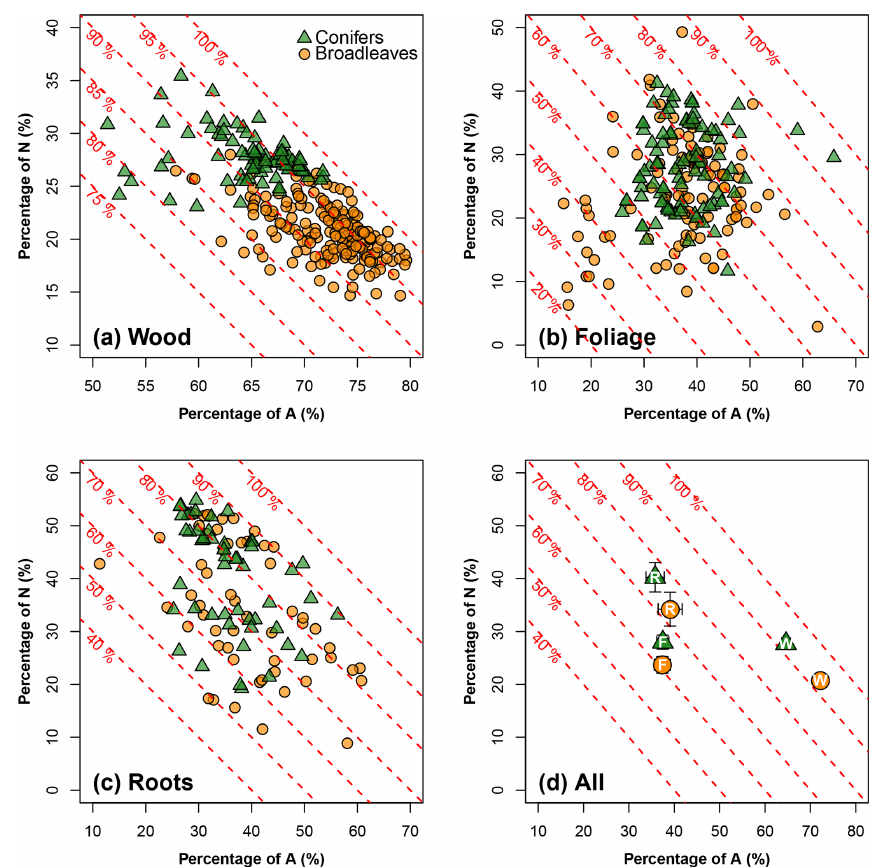
Figure 2. A meta-analysis of the carbon composition for northern temperate tree species: the x axis represents the percentage of acid- hydrolyzable compounds (e.g., cellulose, noted as A; in %), and the y axis represents the percentage of non-soluble and non-hydrolyzable compounds (e.g., lignin, noted as N; in %). The oblique red dashed lines show the sum of A and N and their values. The remaining percentage, i.e., 100 − (A + N) , refers to the portion of non-polar extractives, ethanol or dichloromethane compounds (E), and water soluble compounds (W). Analyses are conducted (a) for wood (106 data points for broadleaves, and 79 for conifers), (b) for foliage litter (106 data points for broadleaves, and 83 for conifers) and (c) for root litter (58 data points for broadleaves, and 49 for conifers). (d) is a statistical summary (symbols and means and error bars – 1.96 × SE) for wood (W), foliage (F) and roots (R) in a common coordinate system. Note the use of different axis graduations in each plot. See Supplement II for the data